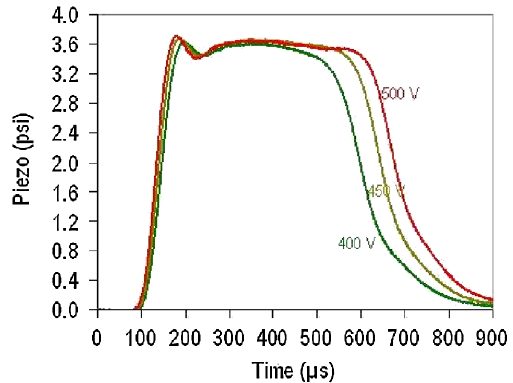
FIG. 12. Piezopressure (psi) vs time for 800 psia He at various capacitor charge voltages.